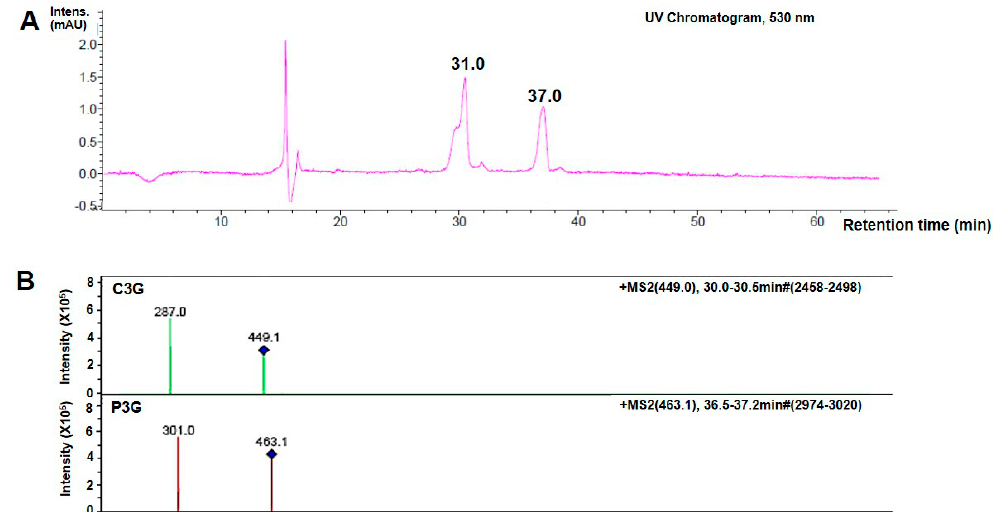
Figure 1. HPLC-electrospray ionization (ESI) mass spectrometry (MS) analysis of anthrocyanins (ANTs) in Oryza sativa L. ( A ) Representative HPLC chromatograms of Cyanidin-3-glucoside (C3G) and Pelargonidin-3-glucoside (P3G) in the extracts at 530 nm. Peaks were detected with a retention time at 31.0 and 37.0 min, identified as C3G and P3G, respectively; ( B ) Fragmentation patterns in the mass spectra of C3G and P3G in the ANT. The assay was performed in triplicate. Table 1. The parameters used for ANT peak identification.